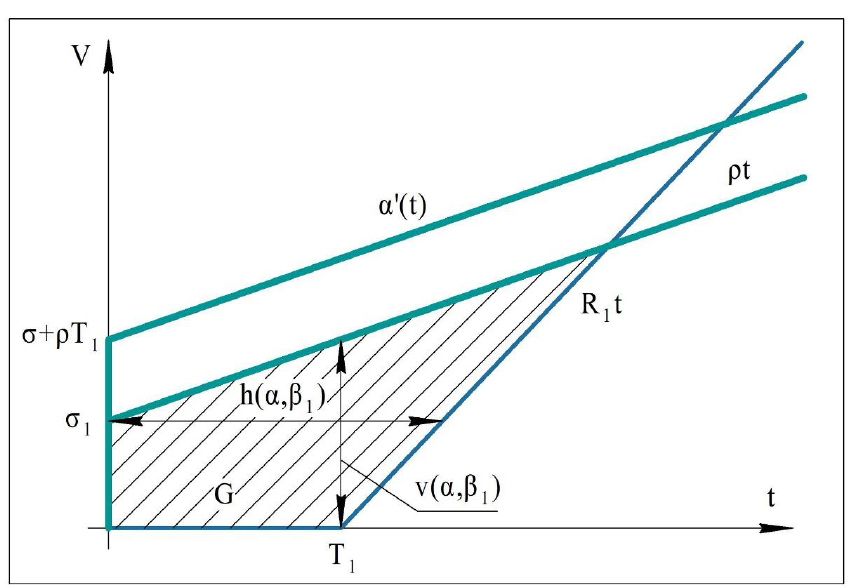
Figure 4. Calculation of upper estimates for lag b(t), delay d(t), and arrival curve α'(t) of the output flow bounded by function а(t)=pt+σ and RL handler with service curve